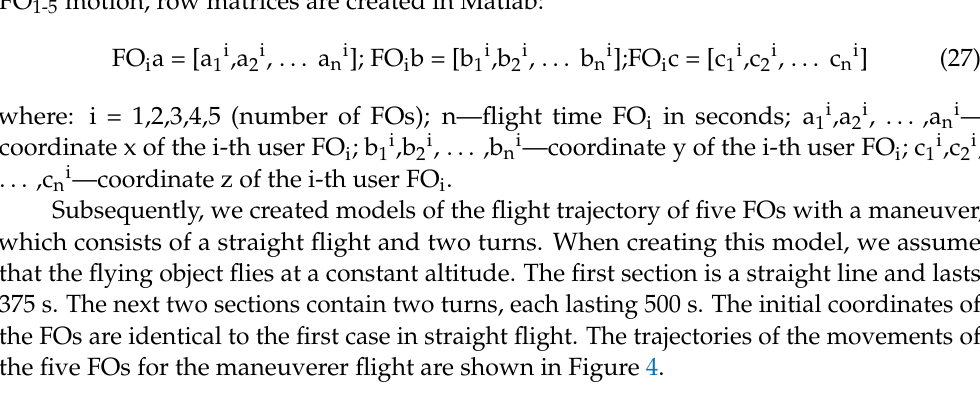
Figure 3 are marked with a black (+) sign and the FO identification mark. When modeling FO 1-5 motion, row matrices are created in Matlab: